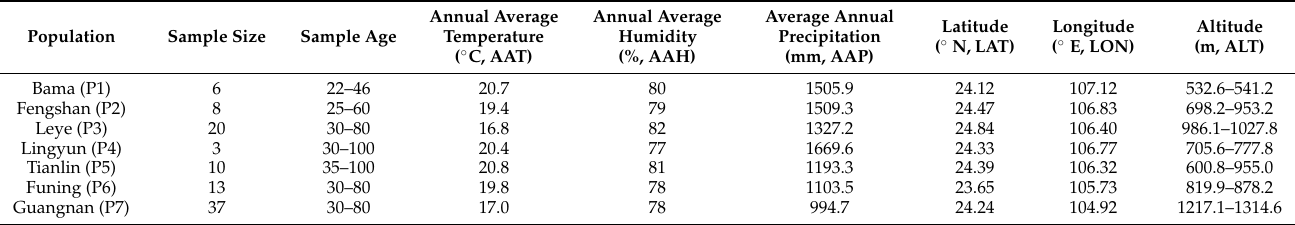
Figure 1. Locations of the seven populations sampled of M. oleifera. Upper panel: A map of China with grey indicating the studied area. Lower panels: The enlarged studied area, where solid black dots indicate the studied populations. Table 1. Population, sample size, age, and geoclimatic factors for seven natural populations of M. oleifera .